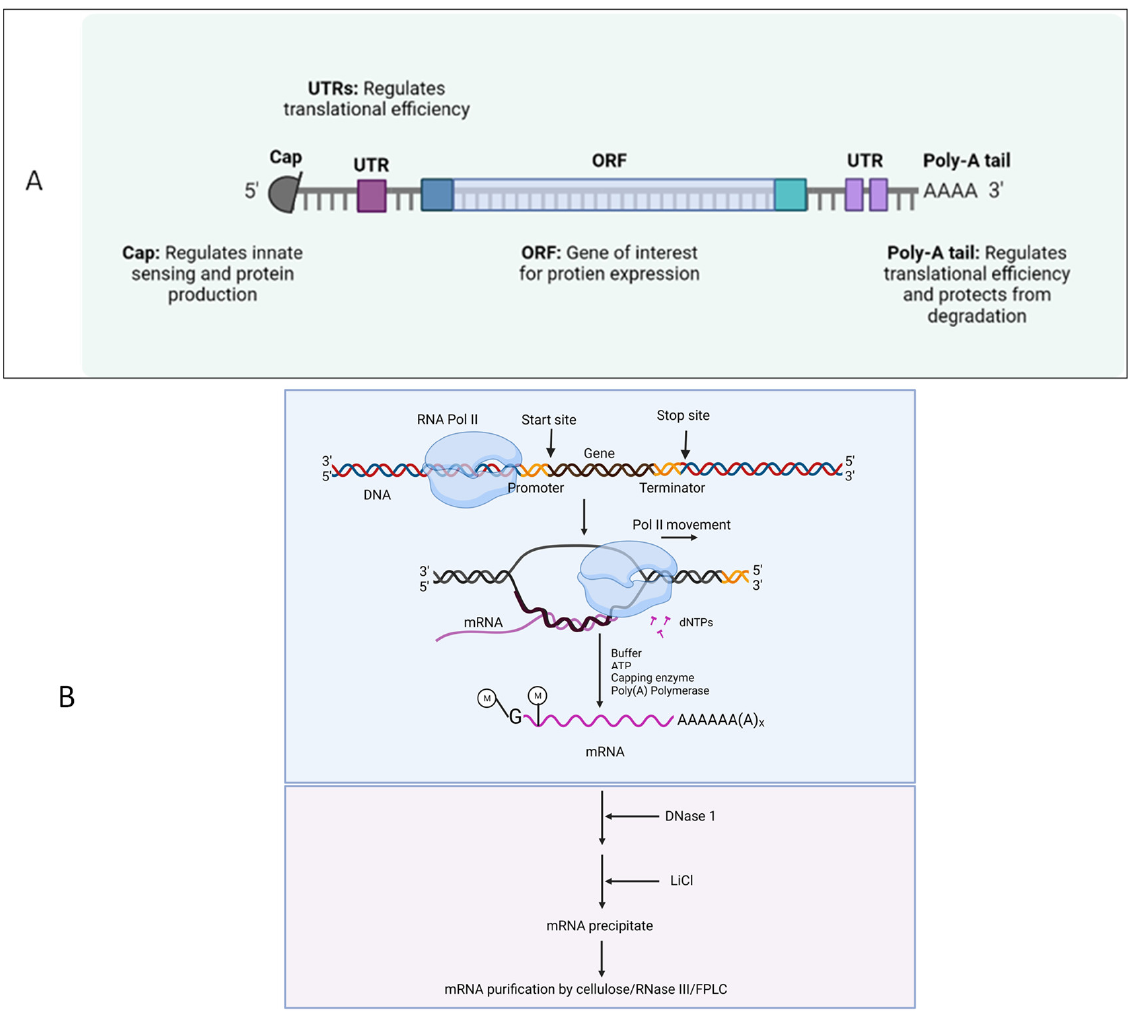
Figure 4. ( A ). Structure and in vitro synthesis of mRNA. The basic structure of mRNA for therapeutics development. Cap, 5′ UTR, ORF, 3′ UTR, and PolyA are the five structural components of